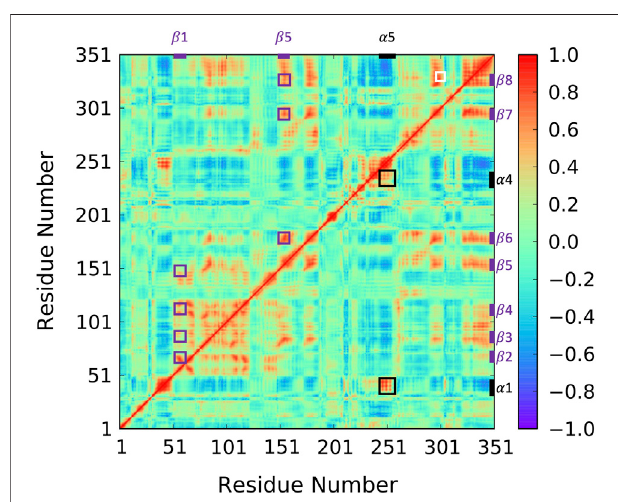
FIGURE 4 | Correlation map for 1-µs GaMD trajectory of Model 6. The correlation between β 1 and β 2 – β 5 as well as the correlation between α 5 and β 6 – β 8 are highlighted using purple boxes. The correlation between insertion helix α 5andinsertionhelices α 1and α 4arehighlightedwithblackboxes. The correlation formed by R299, G328, and D334 is highlighted by a white